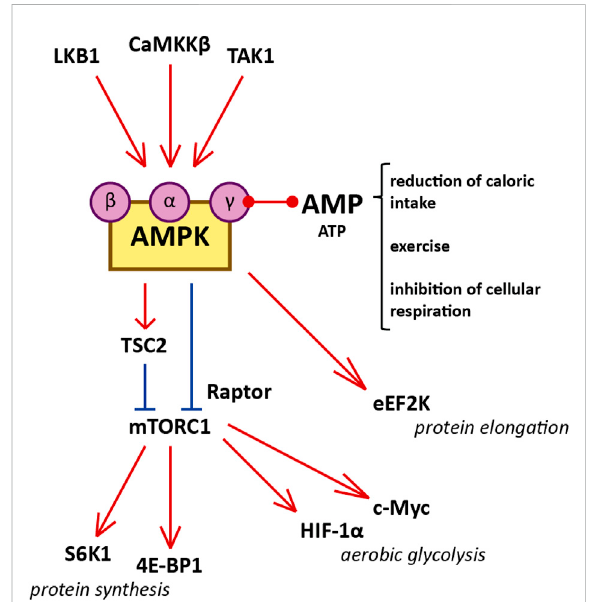
FIGURE 1 Diagram illustrating the interaction between AMPK and mTORC1, and cellular functions of mTORC1 that in fl uence cystogenesis in ADPKD. Red represents activation and blue represents inhibition. AMPK is a heterotrimer consisting of a catalytic α -subunit, a regulatory β -subunit, and a regulatory γ - subunit assembled in a 1:1:1 ratio. Reduced caloric intake, physical exercise, and interference with electron transport in the mitochondria increase the AMP/ATP ratio. Binding of AMP to the regulatory γ -subunit of AMPK allows the catalytic α -subunit to be phosphorylated at residue Thr172 by one of the three AMPK kinases (LKB1, CaMKK β , and TAK1). Certain molecules, such as salicylate, can activate AMPK directly by binding the β -subunit. After phosphorylation by the AMPK kinases, AMPK inhibits mTORC1 1) by phosphorylating the Raptor component of the complex (at residues Ser722 and Ser792) and 2) by phosphorylating TSC2 (at residues Thr1227 and Ser1345). The inhibition of mTORC1 suppresses protein synthesis